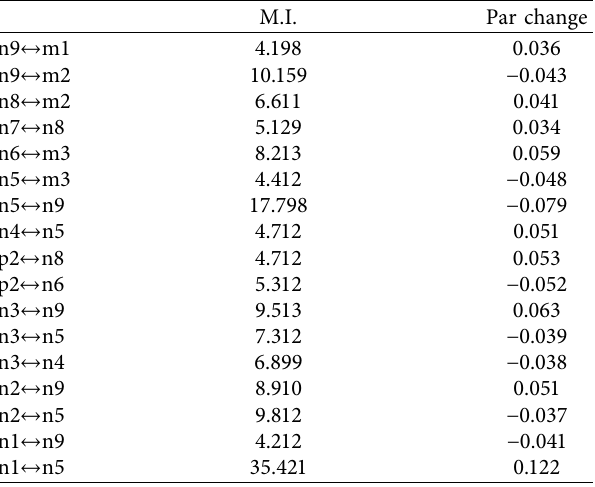
Table 6: MI values of covariance. Table 7: MI values of regression